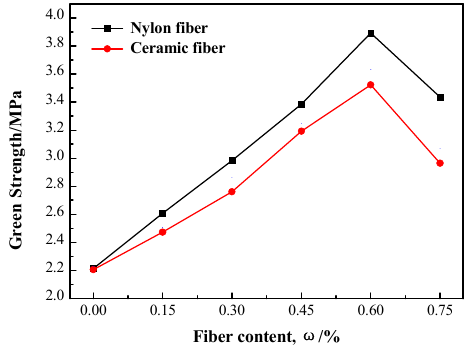
Figure 4. E ff ect of fiber content on the wet strength of investment casting Figure 4. Effect of fiber content on the wet strength of investment casting shell.